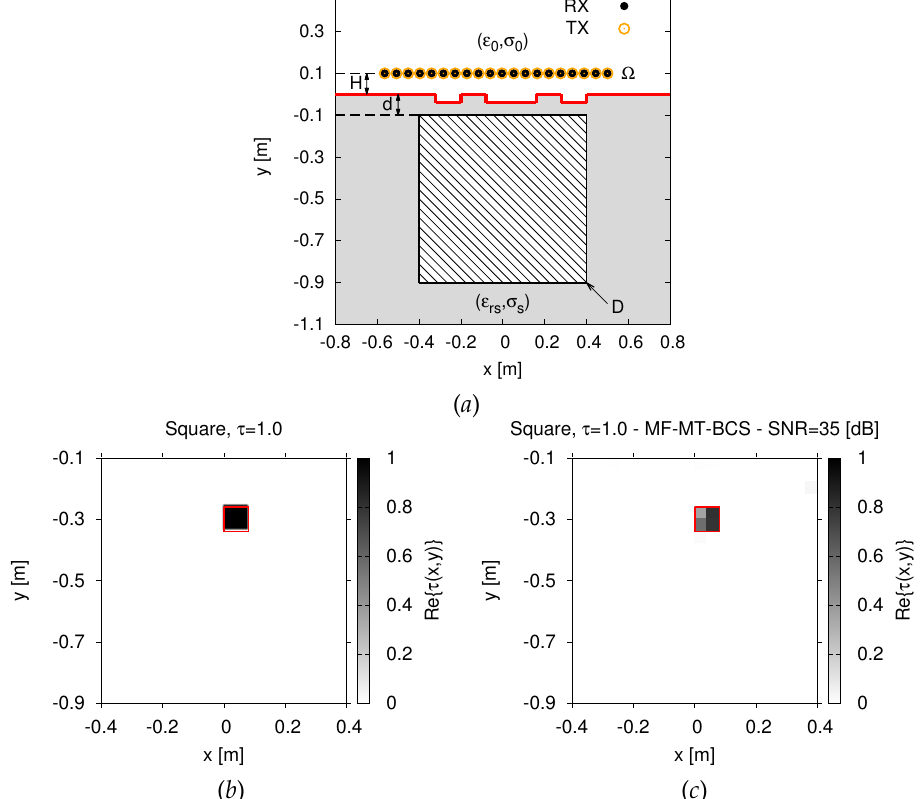
Figure 8. Numerical assessment (“ Square-Shaped ” Scatterer , τ = 1.0, N = 400, SNR = 35 dB)—Imaging scenario ( a ) and actual ( b ) and retrieved ( c ) dielectric profile by the MF-MT-BCS when considering a non-planar air–soil